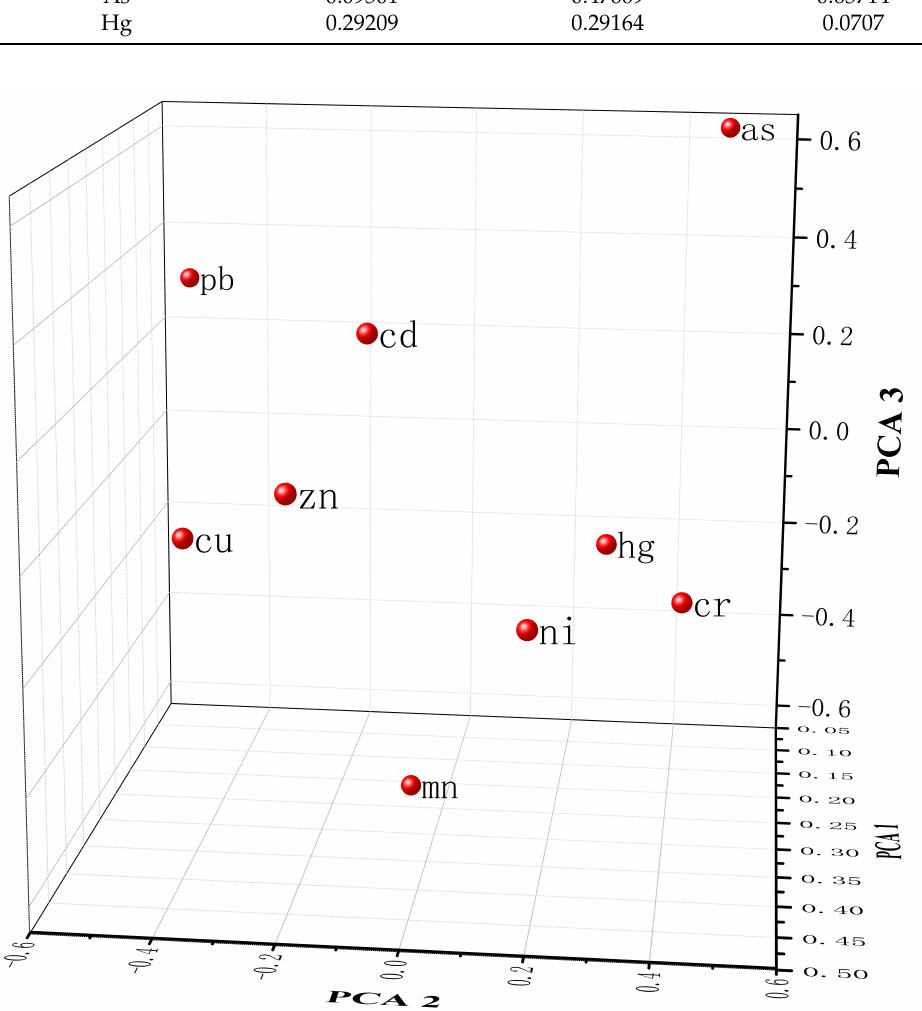
Figure 8. Principal component analysis (PCA) load diagram of heavy metal concentration in farmland soils of Shaanxi Province. There are three principal components greater than 1, and their characteristic values are 3.335, 1.414, and 1.038. Their cumulative variance contribution rates are 37.06%, 52.78%, and